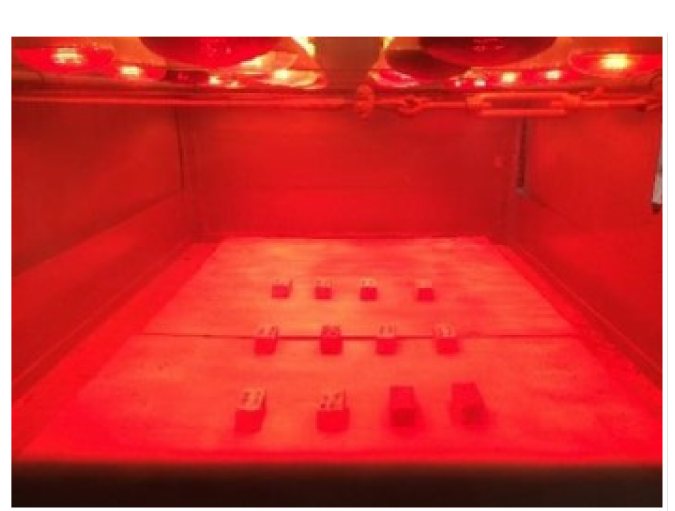
Figure 14. Infrared aging chamber at 60 ± 2 ◦ C.